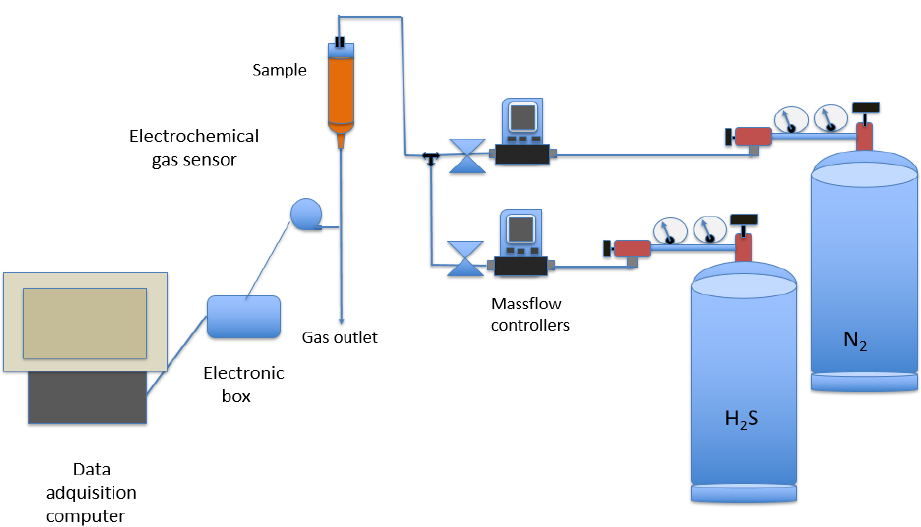
Figure 9. Schematic view of the setup used to investigate H 2 S uptake onto the adsorbent. Exiting H 2 S concentration from the column was measured online by an Amphenol SGX Sensortech 4 series electrochemical gas sensor (Sensortech, Corcelles-Cormondreche,